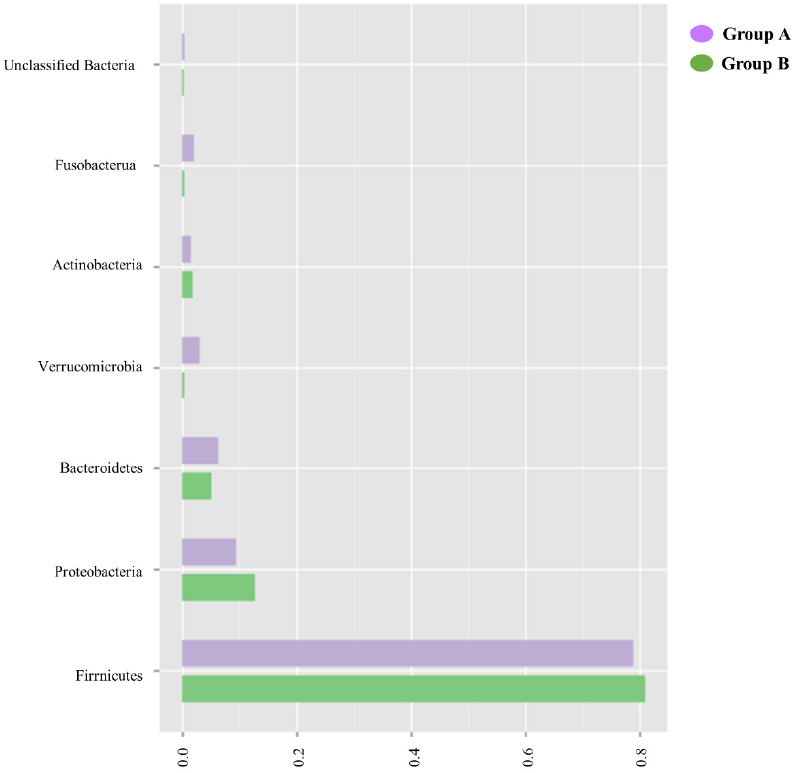
Figure 3. Fecal microbiome analysis comparison of Groups A and B at the phylum level. Overall, the phyla of these groups are similar to each other in composition, with the largest composition being of Firmicutes and the smallest of unclassified bacteria.